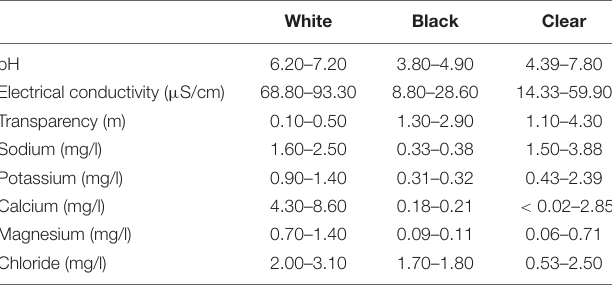
TABLE 1 | Limnologic characteristics of Amazonian white, black and clear water